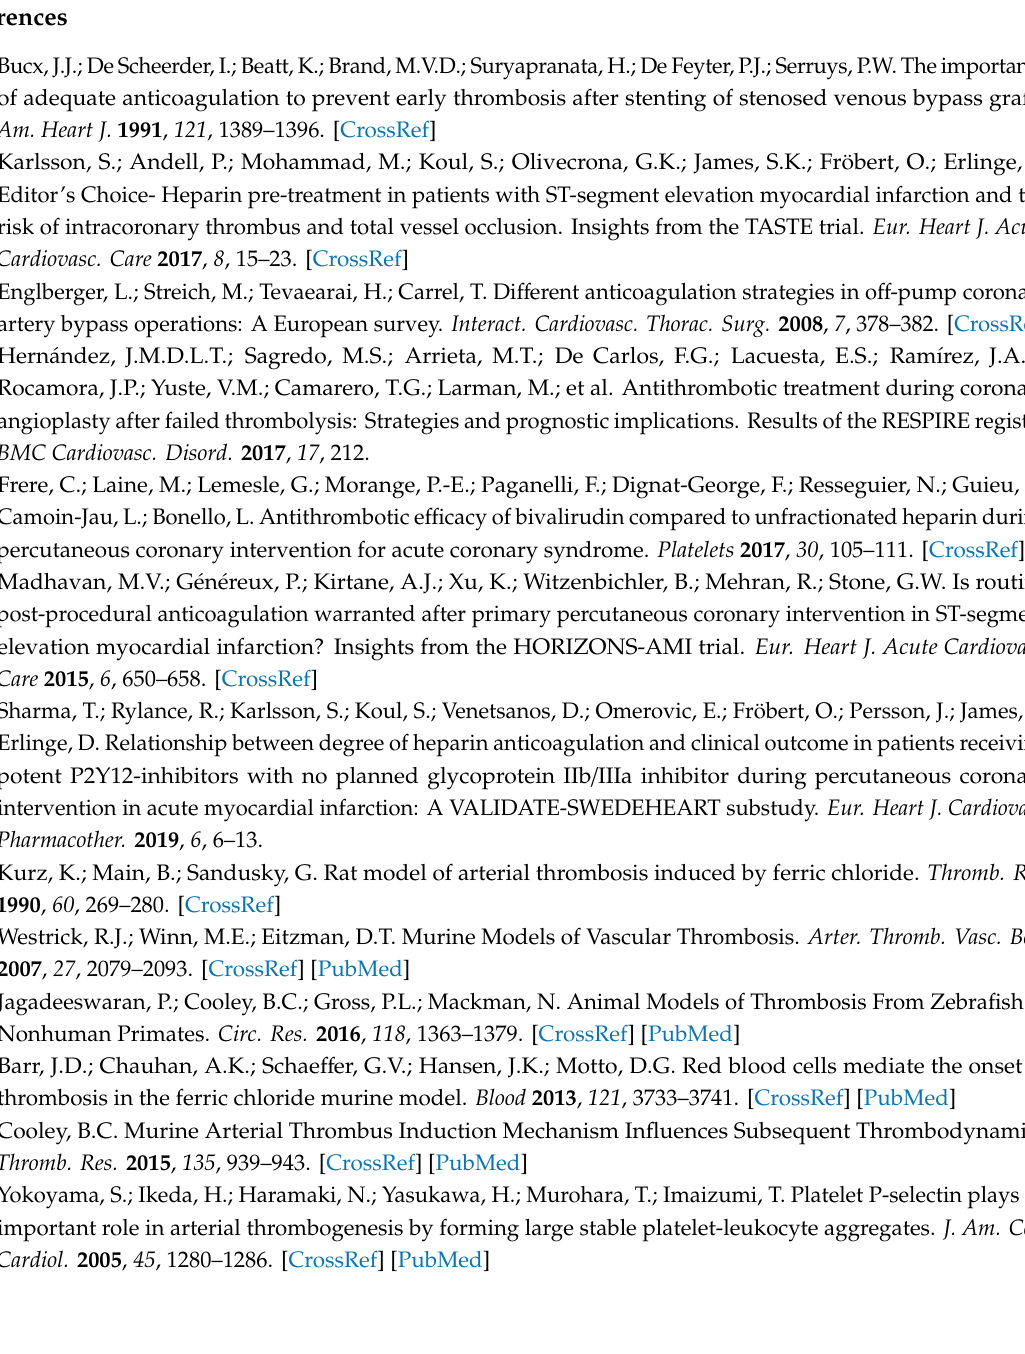
normalized baseline value of 1 for all traces, regardless of initial baseline flow (which varied among animals). Figure S3: All data traces for the group with heparin infused 5 min after the TTO (Group 3), using the same criteria for graphing as in Supplemental Figure S1. Figure S4: All data traces for the control group (saline infused) at the time of TTO (Group 4), using the same criteria for graphing as in Supplemental Figure S1. Figure S5: “Survival Curve” style of graphic portrayal of the TTO data, stepping down the group number (%) as occlusion occurred (time) in each group. The TTR was not included as this created a more chaotic portrayal due to multiple reflow events in some lines after the first reflow event (TTR), causing a lot of up / down direction changes. Author Contributions: A.B.M. and B.K. provided technical support for this study, carrying out the majority of the experiments. B.C.C. conceived of the study and its design and wrote the manuscript. All authors have read and agreed to the published version of the